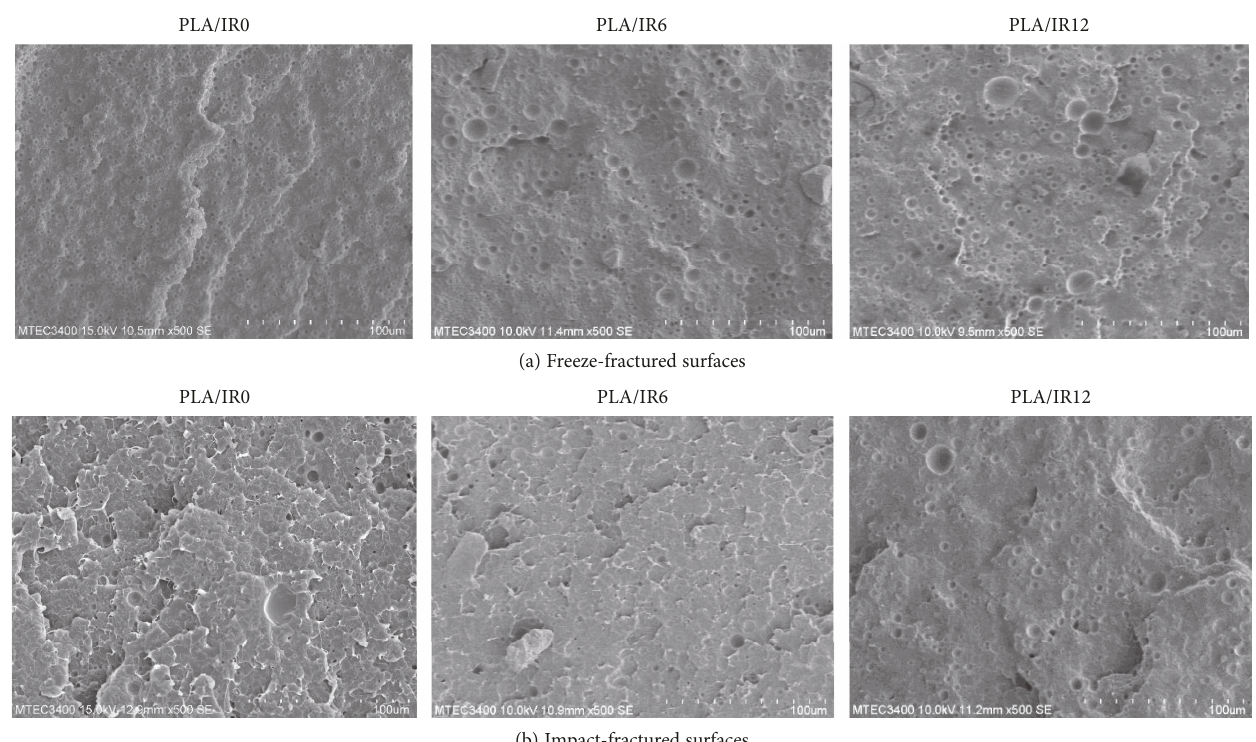
Figure 11: SEM micrographs at 500x of PLA/IR blends using IR masticated for di ff erent mastication times.